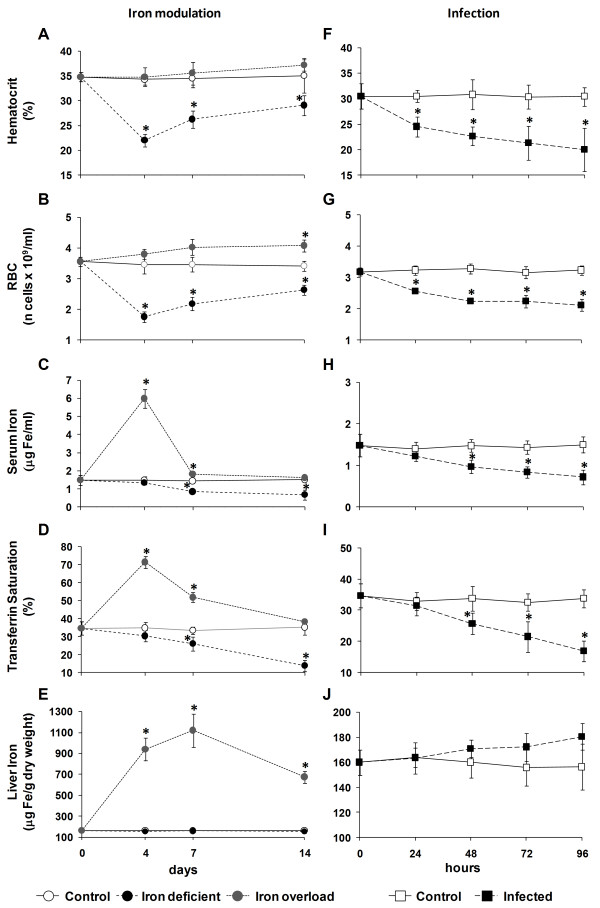
Hematological parameters kinetics in iron modulated and infected fish. Iron modulation: (A) hematocrit, (B) red blood cells count (RBC), (C) serum iron, (D) transferrin saturation and (E) liver iron; Infection: (F) hematocrit, (G) red blood cells count (RBC), (H) serum iron, (I) transferrin saturation and (J) liver iron. Values are expressed as means ± S.D. (n = 5 or n = 6 for iron modulation or infection, respectively). Samples were collected at 4, 7 and 14 days after iron modulation or 24, 48, 72 and 96 hours post-infection. Untreated fish were used as a 0-day control (n = 5). Differences from the controls were considered significant for *p < 0.05.